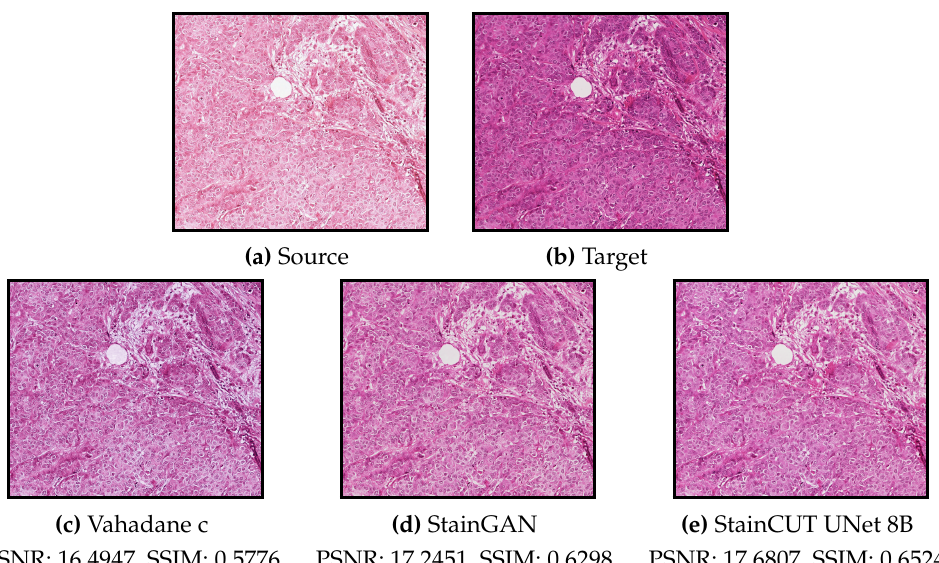
Figure 14. Exemplary source frame (a) where the stain transfer results (c, d, and e) do not quite Figure 15. Exemplary source frame ( a ) where the stain transfer results ( c – e ) do not quite match the expected one ( b ). The content of the image is preserved in all cases. The images correspond to whole match the expected one (b). The content of the image is preserved in all cases. The images frames, i.e., the result frames are the result of combining several stained patches by the method correspond to whole frames, i.e., the results frames are the result of combining several stained described in Section patches by the method described in Section 4.3.